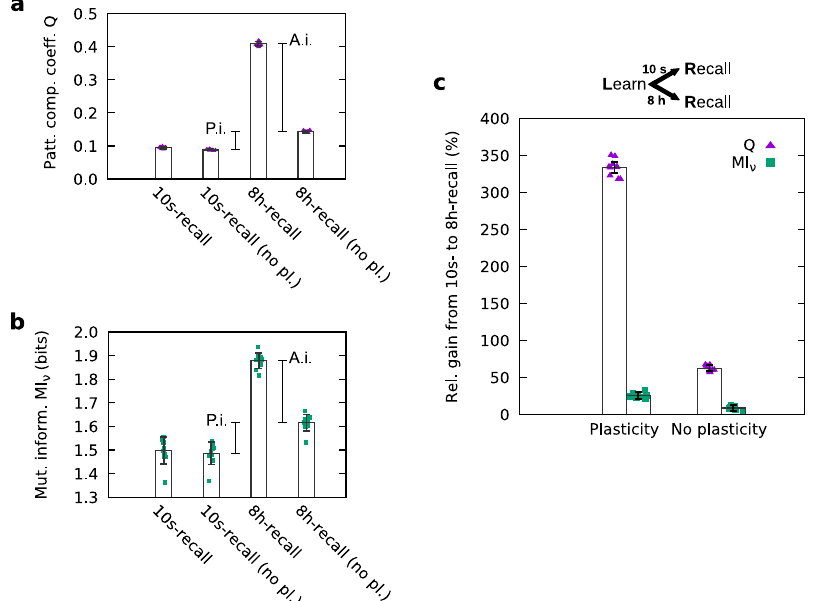
Fig. 7 Recall quality measured for recall 10 s and 8 h after learning with and without early-phase synaptic plasticity during recall. The effect of early- phase synaptic plasticity on the total improvement is signi fi cant (compare 8h-recall with 8h-recall no pl.: A.i. active improvement), but it does not cover the complete level of improvement (compare 10s-recall with 8-h recall no pl.: P.i. passive improvement). a Pattern completion coef fi cient Q ; b mutual information MI ν ; and c relative gain in Q and MI ν from 10s-recall to 8h-recall. All observables averaged across ten trials. Error bars indicate standard deviation across the ten trials in a , b and the propagated error in c . Parameter setting: w ie / h 0 = 4, w ii / h 0 = 4, n CA = 350 (value of the maximum in Fig. 5c,